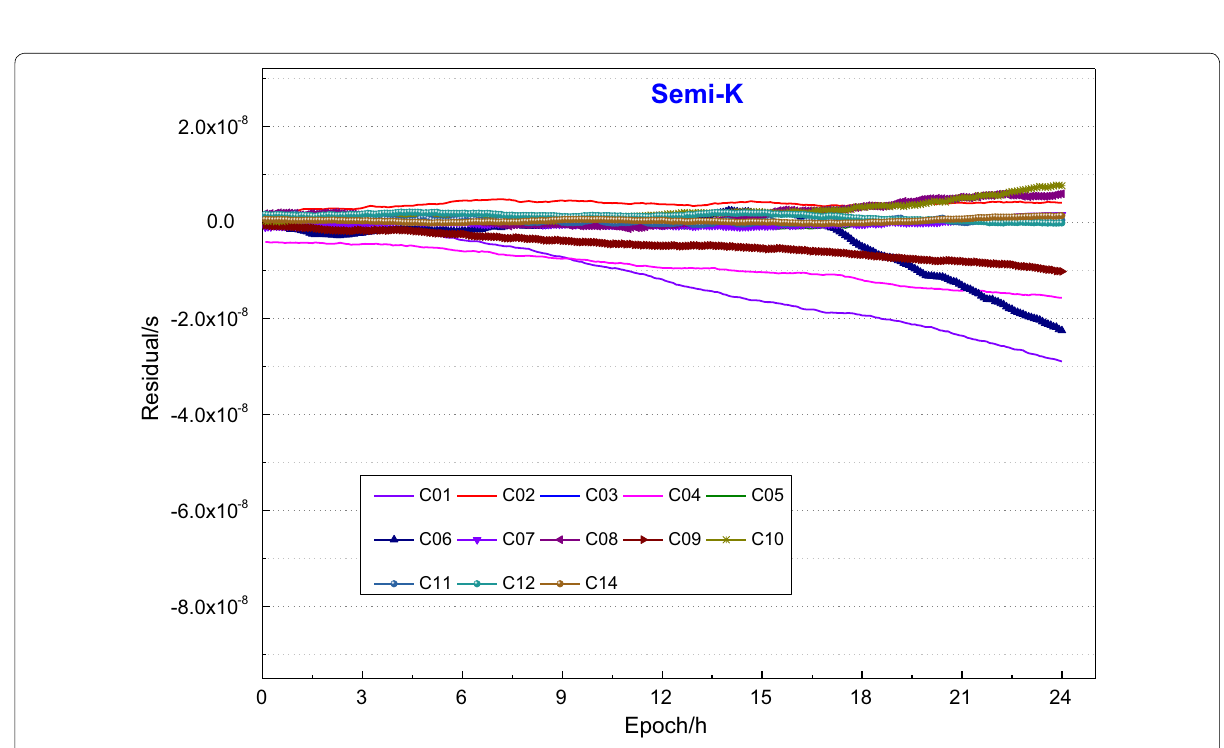
Fig. 6 24 h prediction residual sequence of Semi-K